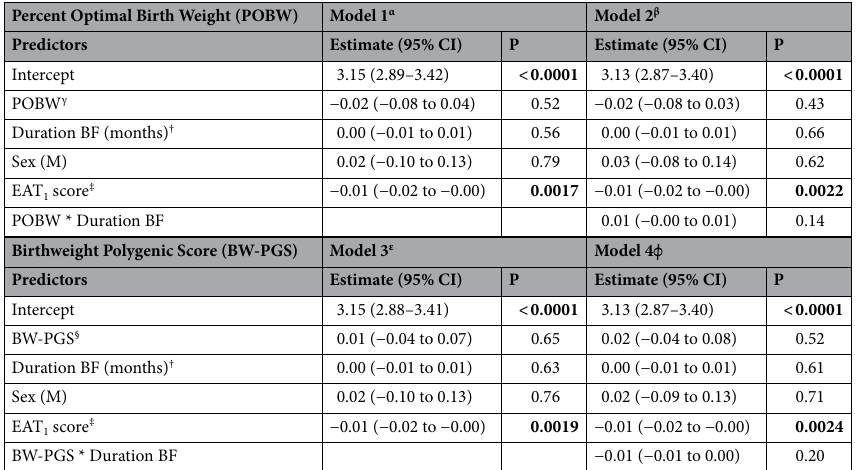
Table 5. Association analyses for Fasting Low-Density-Lipoprotein-Cholesterol (mmol/L). γ POBW = Percent Optimal Birth Weight (standardised); † Duration of BF = Duration of any breastfeeding (mean-centred); ‡ EAT 1 score = quality of early life nutrition in first year of life; § BW-PGS = birth weight polygenic score (standardised); δ adjustment for population stratification; α Model 1 examines the effect of duration of breastfeeding adjusting for POBW, sex and EAT 1 score; β Model 2 examines the effect modification of duration of breastfeeding by POBW adjusting for sex and EAT 1 score; ε Model 3 examines the effect of duration of breastfeeding adjusting for BW-PGS, sex, EAT 1 score and the first two principal components [PCs] (estimates not presented); 4 examines the effect modification of duration of breastfeeding by BW–PGS adjusting for sex, EAT 1 score and the first two principal components [PCs] (estimates not